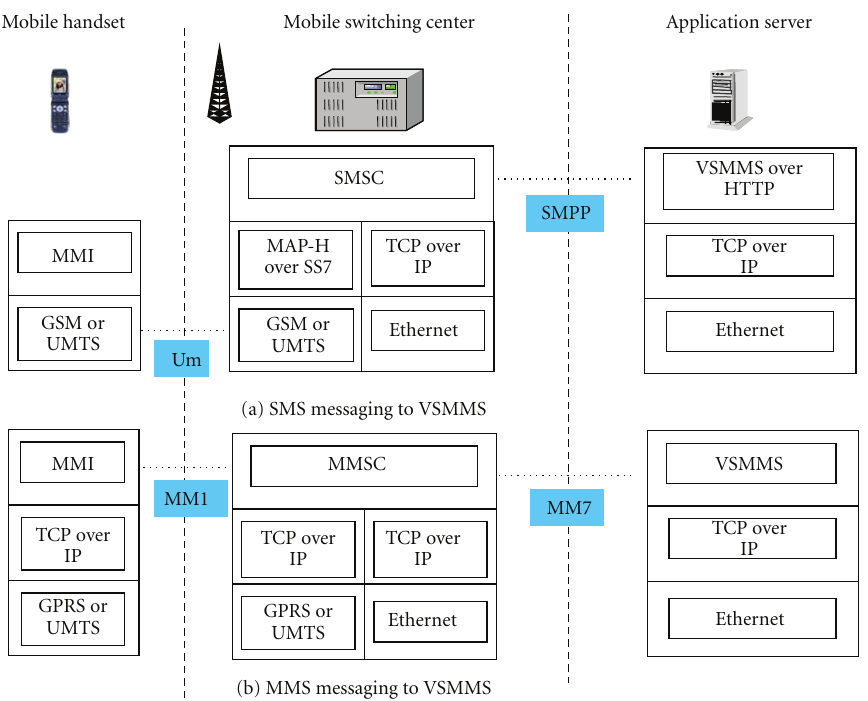
Figure 3: SMS/MMS messaging to VSMMS protocol stack.